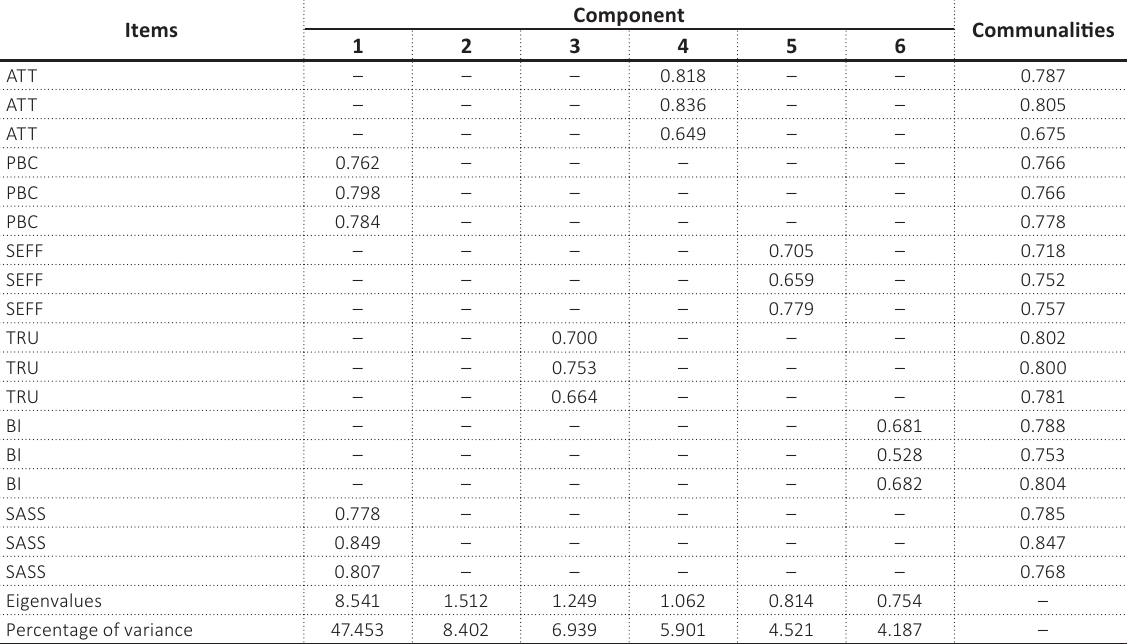
Table 2. Principal component analysis